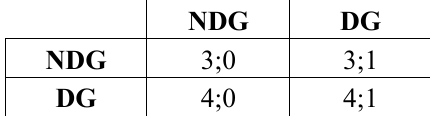
Table 6. The OSA table of DG